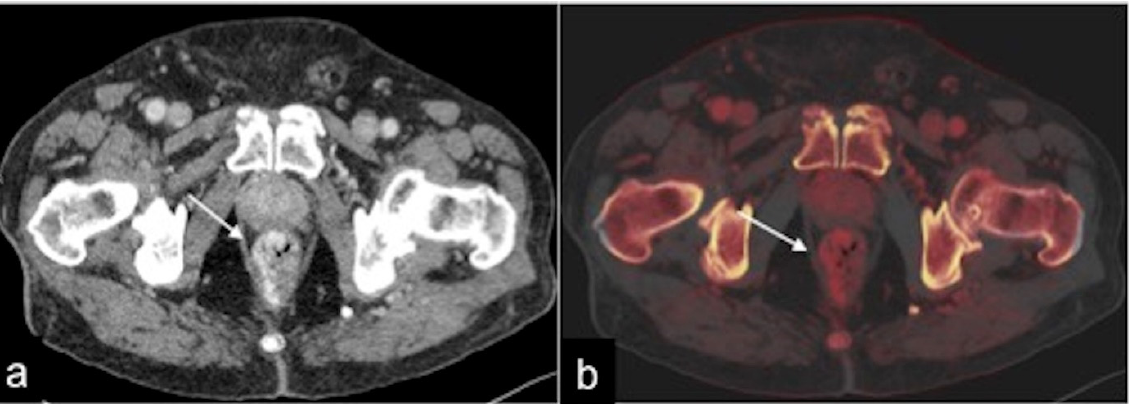
Figure 34. CTA multiphasic study of hepatic colon flexure angiodysplasia. In the arterial phase ( a ) and MIP reconstruction ( b ), it is possible to detect a haemorrhagic focus contiguous to a series of tortuous blood vessels in the colon wall ( a , b , arrow).